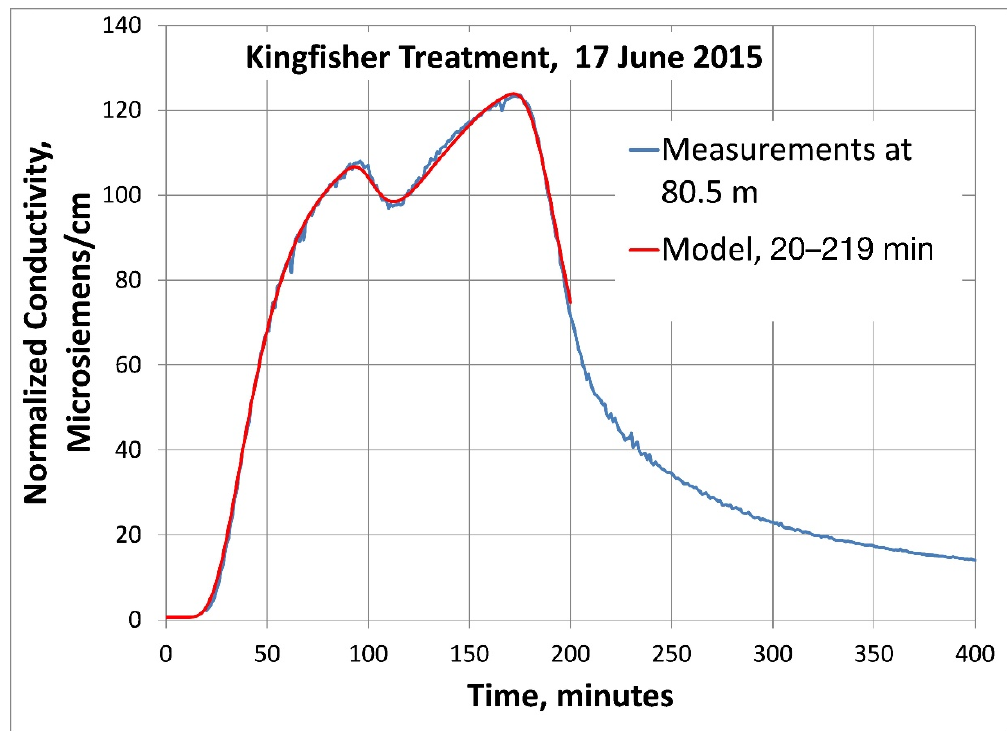
Figure 13. NaCl tracer test comparison of normalized measured values versus model predictions, Kingfisher Treatment site.